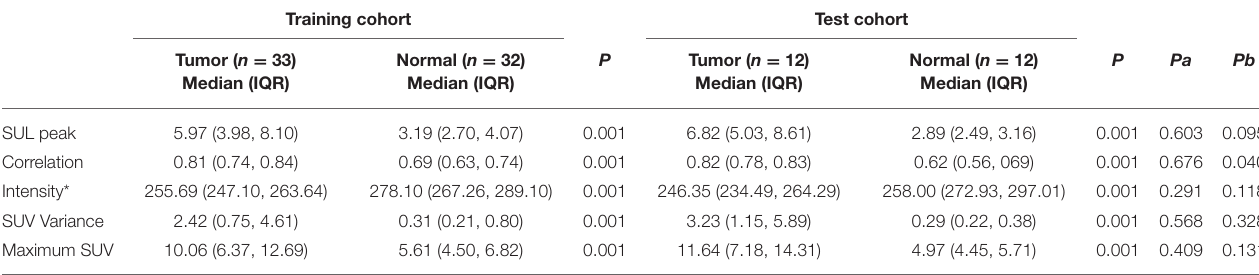
TABLE 2 | Differences in the overall distribution of parameters with good diagnostic value between the benign and malignant groups. Training cohort